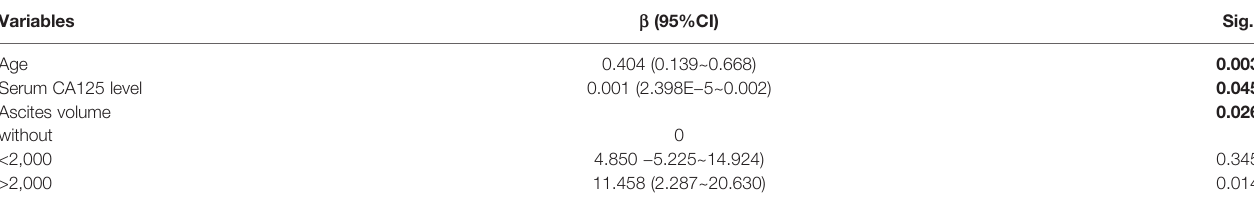
TABLE 4 | Multivariate analyses for Tsen CD8 + T cells in the peripheral blood. Variables b (95%CI)